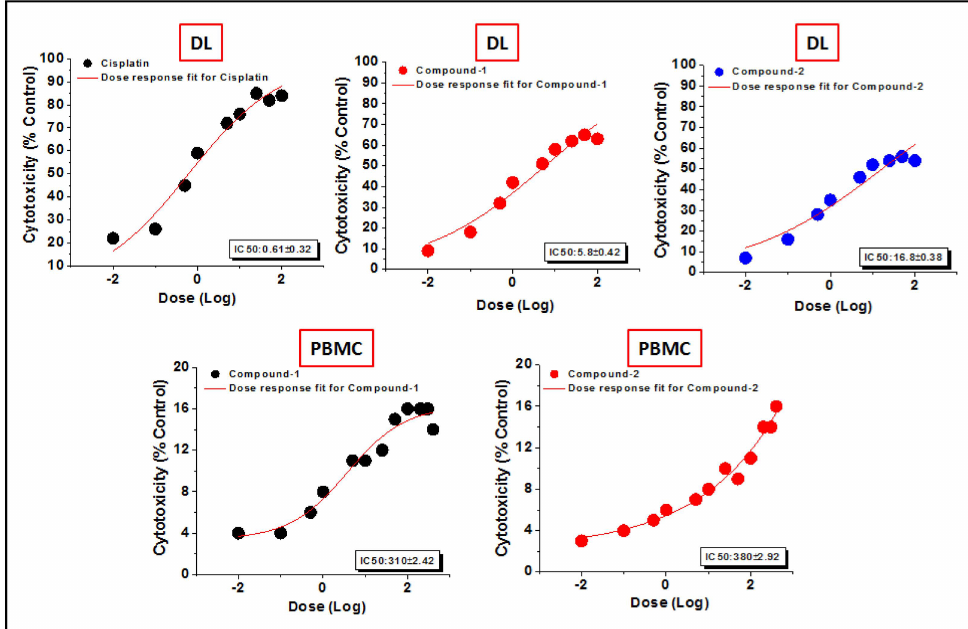
Figure 14. The dosage response curves of compounds 1 and 2 to determine the IC 50 values in DL and PBMC cell